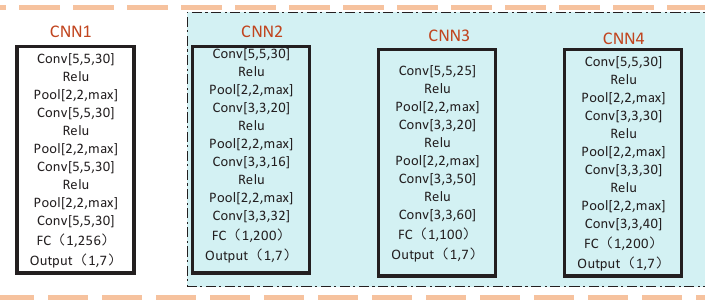
Figure 9. Different architectures of the four designed CNNs. The four models work in parallel. The probability vector expression of an expression is obtained for each model, and the final expression probability value is obtained through the weighted fusion